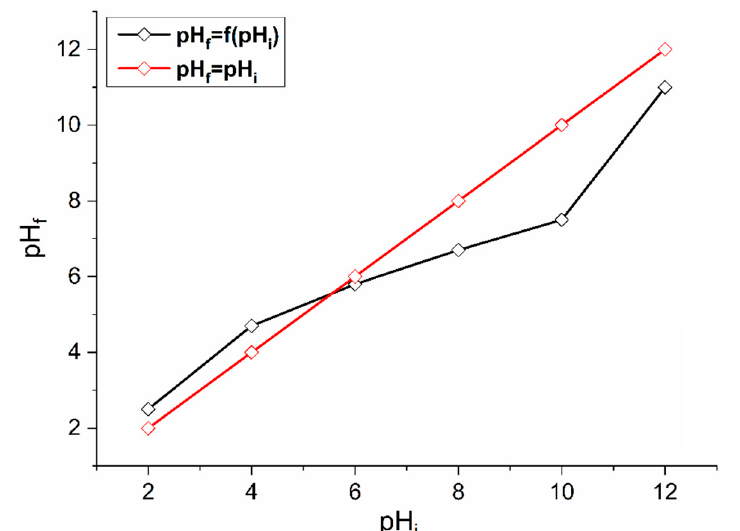
Figure 4. pH pzc determination of AS.